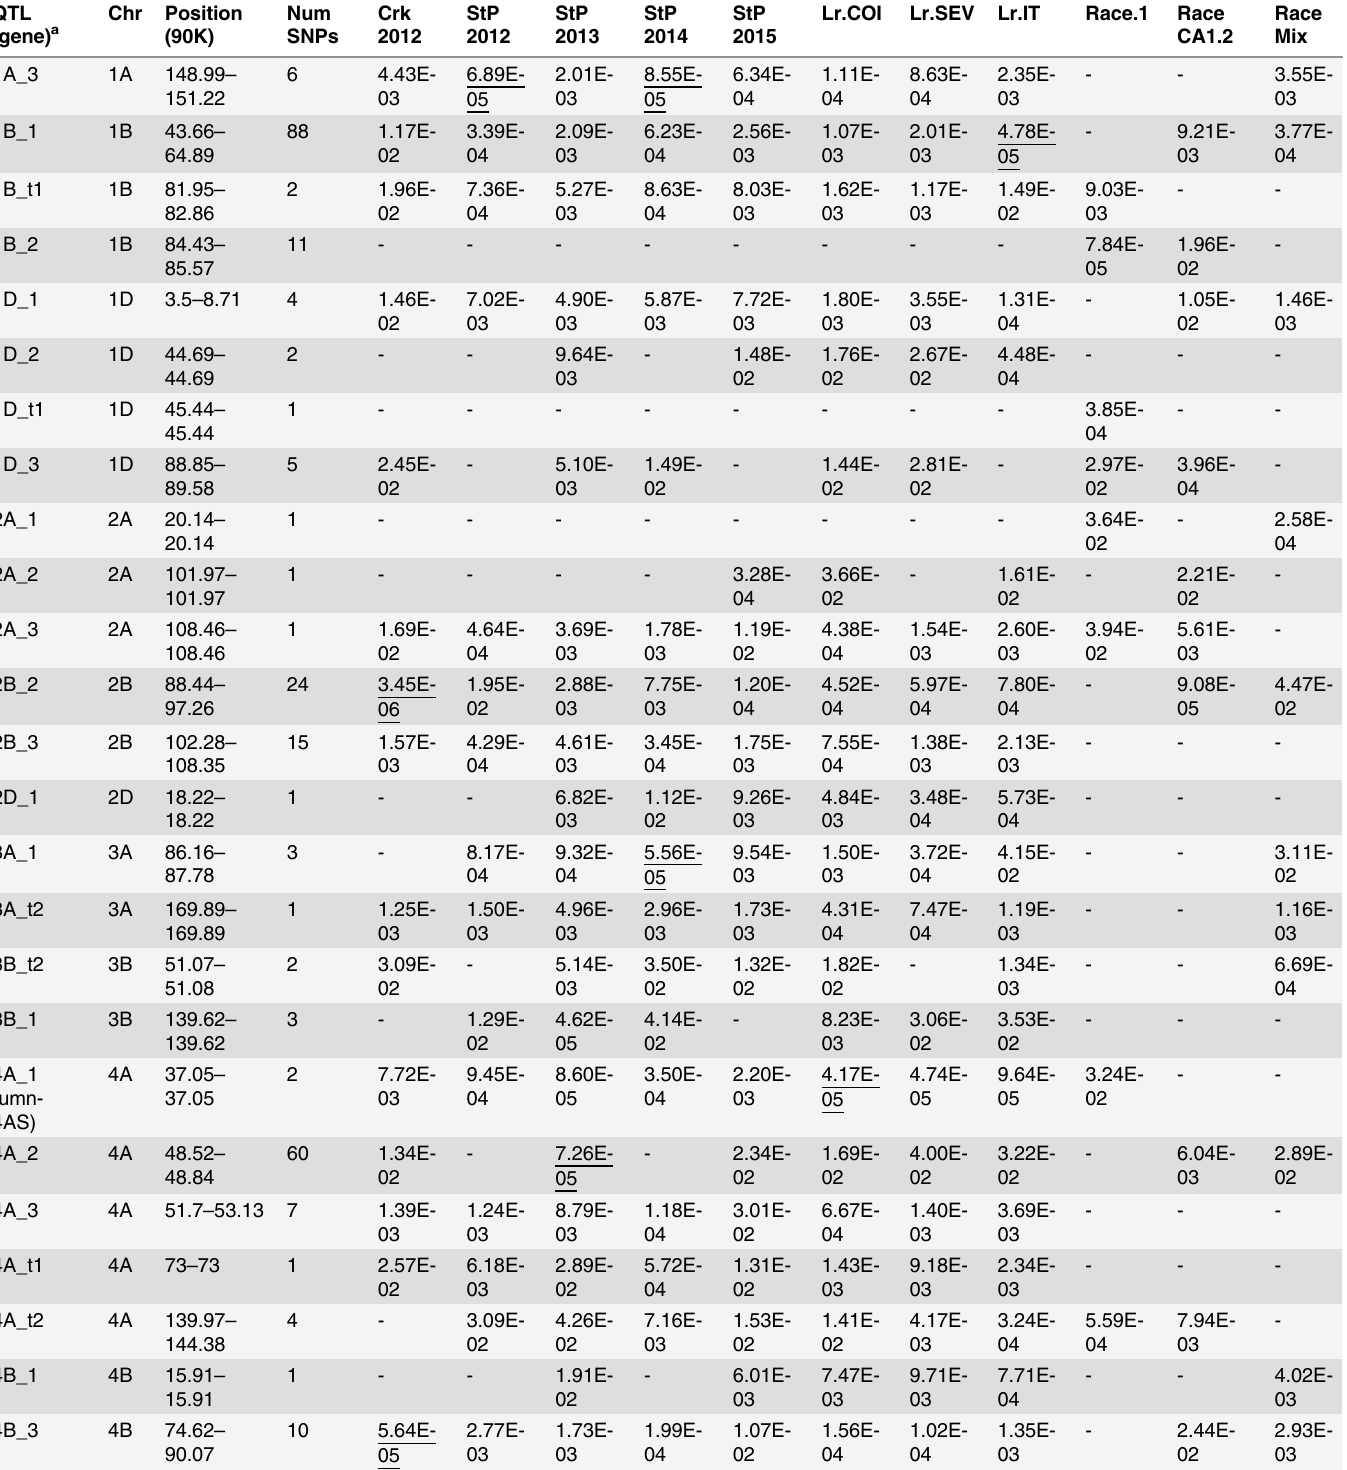
Table 2. A total of 46 QTLs were identified that were significantly associated with field or seedling leaf rust disease resistant (p.MLM < 0.001). QTL (gene)